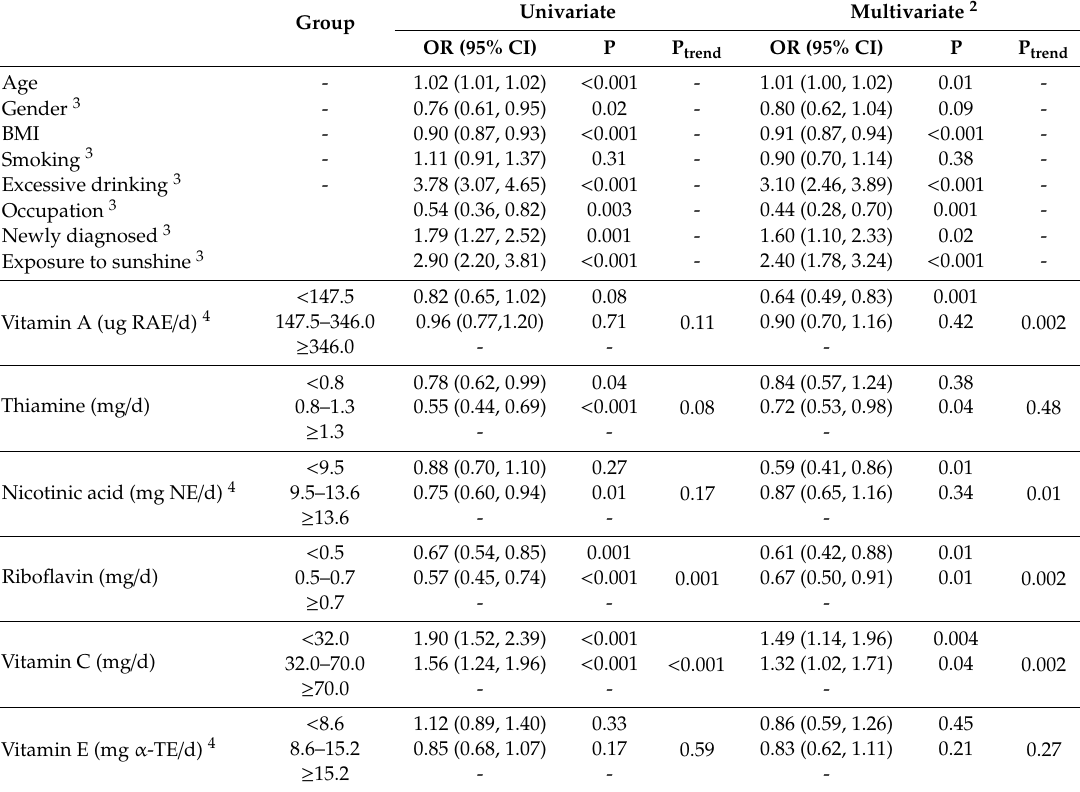
Table 3. Association of the dietary micronutrient intake with the TB score 1 at the end of Week 2 antituberculosis